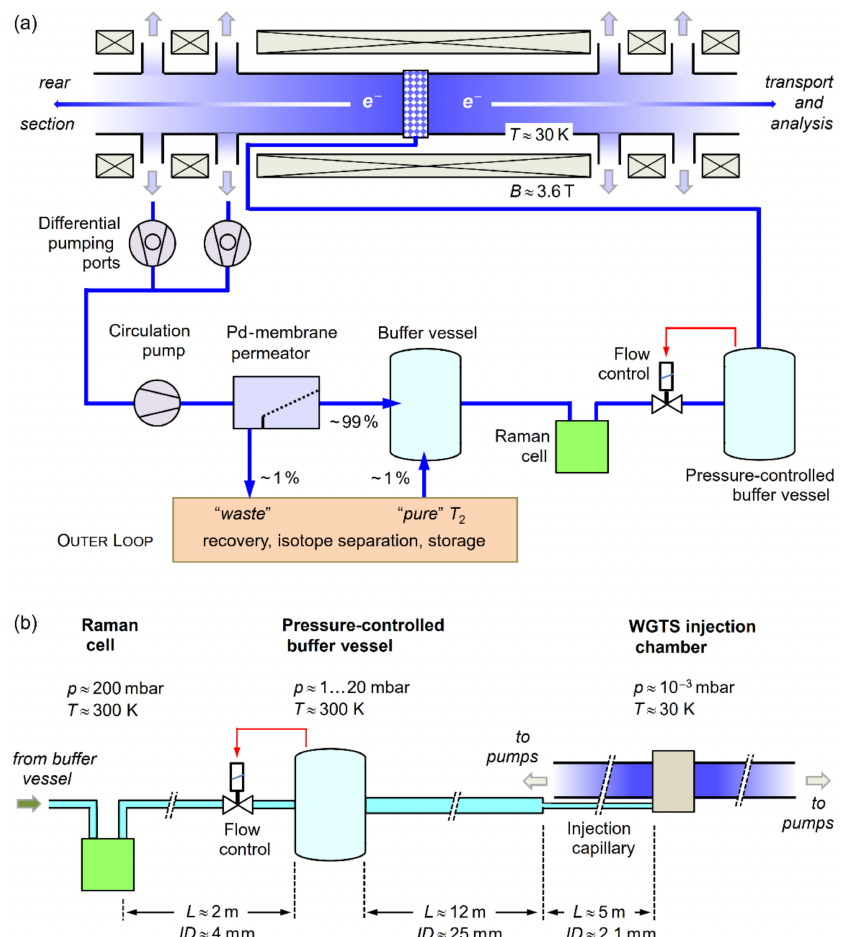
Figure 1. Concept of the gas circulation through the WGTS. ( a ) Schematic simplified diagram of the inner loop, incorporating the WGTS component group; note that, for clarity, not all di ff erential pump port connections to the loop are drawn. The link to the outer loop of the TLK infrastructure for recovery, isotope separation, and storage is included conceptually. ( b ) Selected technical details of the loop segment from the Raman cell to the WGTS injection chamber; relevant numerical values for dimensions— L and ID ( = inner diameter)—and operating parameters— p and T— are